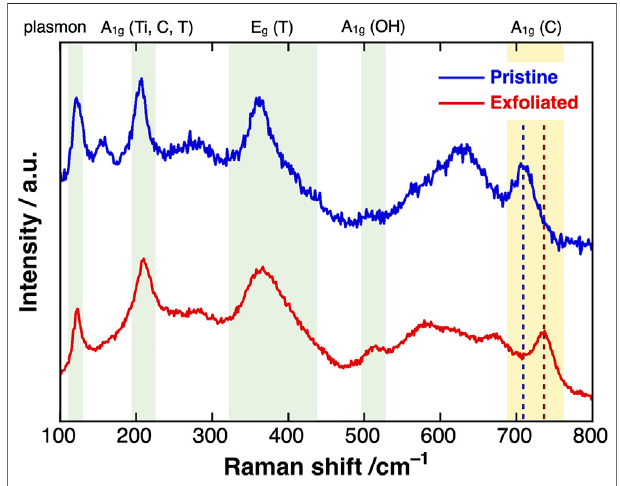
( Figure 2C ). Because tiny defective pinholes were detected on the surface of the large MXene sheet ( Figure 2A ), it appeared that sonication proceeded by tearing the sheets into small pieces. In the macroscale fi lm, the sheet resistance would be increased by the